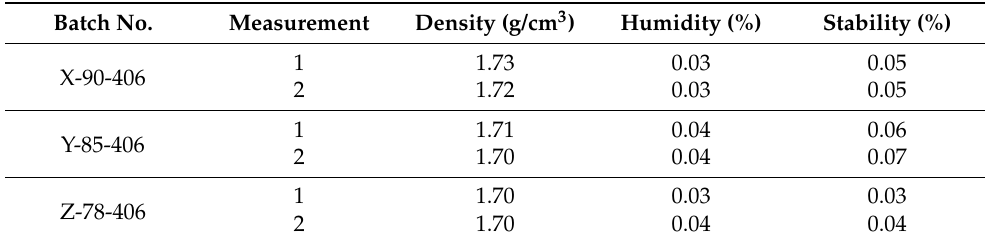
Table 7. Results of density, moisture, and stability analyses of A-IX-1 explosive composition samples extracted from PG-7 warheads.